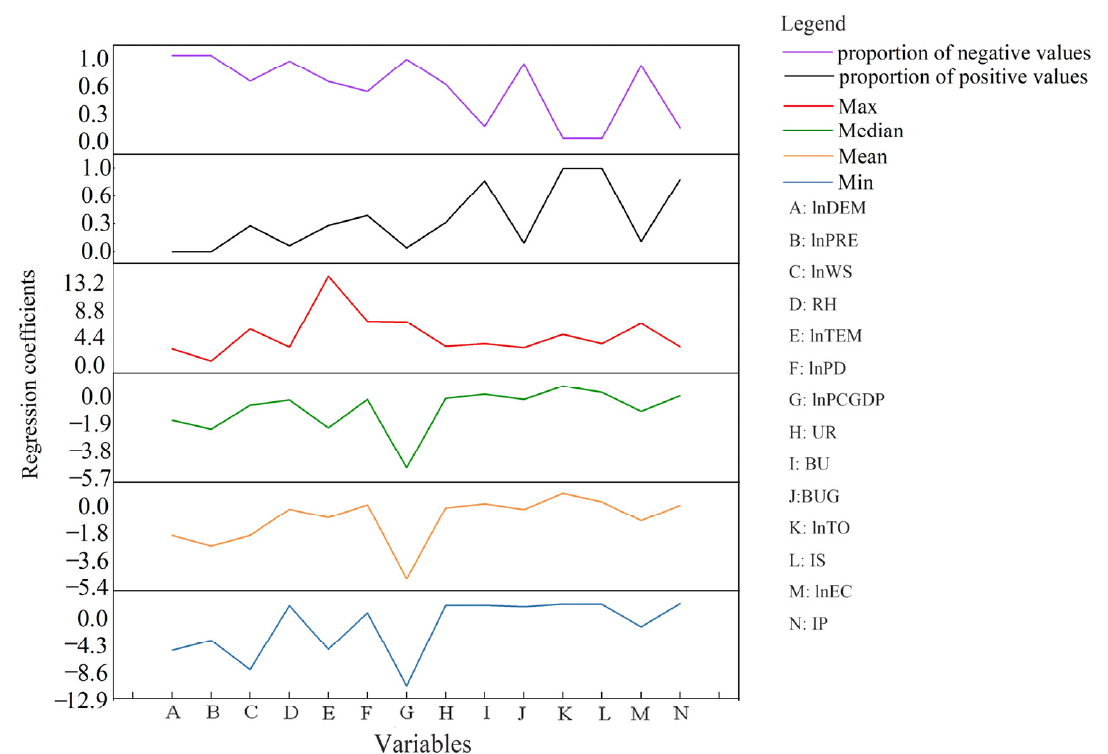
Figure 4. Description statistics of GTWR parameter estimation. Note: DEM: altitude; PRE: precipi- tation; TEM: temperature; RH: relative humidity; WS: wind speed; PD: population density; PCGDP: per capita GDP; UR: urbanization rate; BU: built-up area divided by urban area; BUG: greening area divided by built-up area; TO: trade openness; IS: the ratio of the added value of secondary industry; EC: electricity consumption; IP: invention patents.